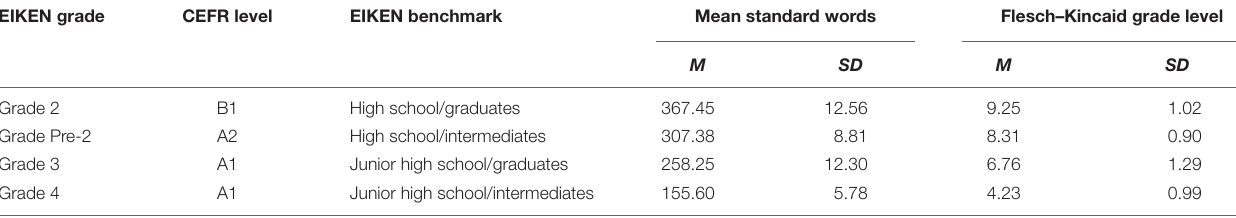
TABLE 4 | EIKEN grades and their Common European Framework of Reference for Languages (CEFR) level with text variables.